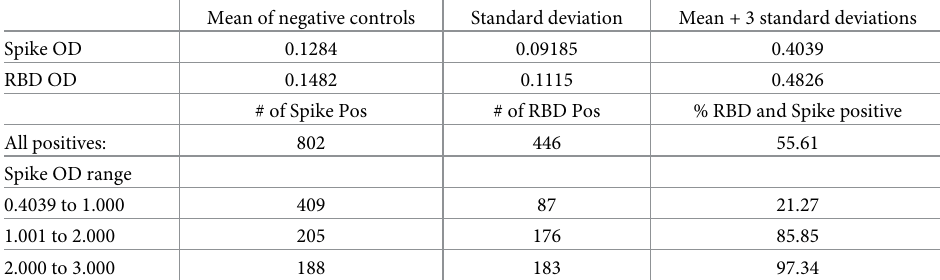
Table 1. Mean S and RBD raw ELISA OD values for setting the assay baseline and the resulting 802 positive sam- ples separated by assay reactivity.